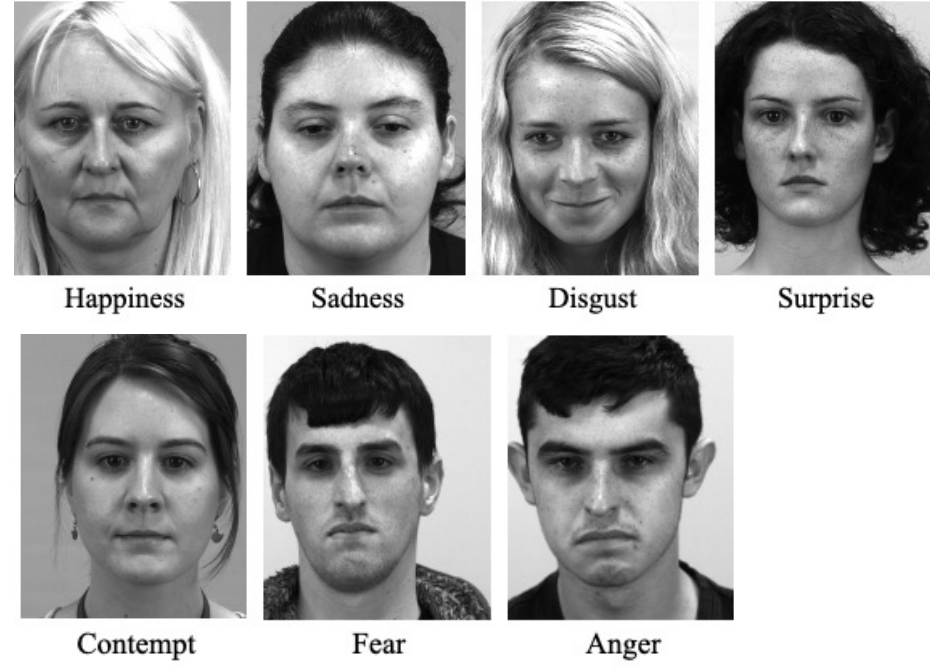
Figure 12. Examples of images from the SAMM data set